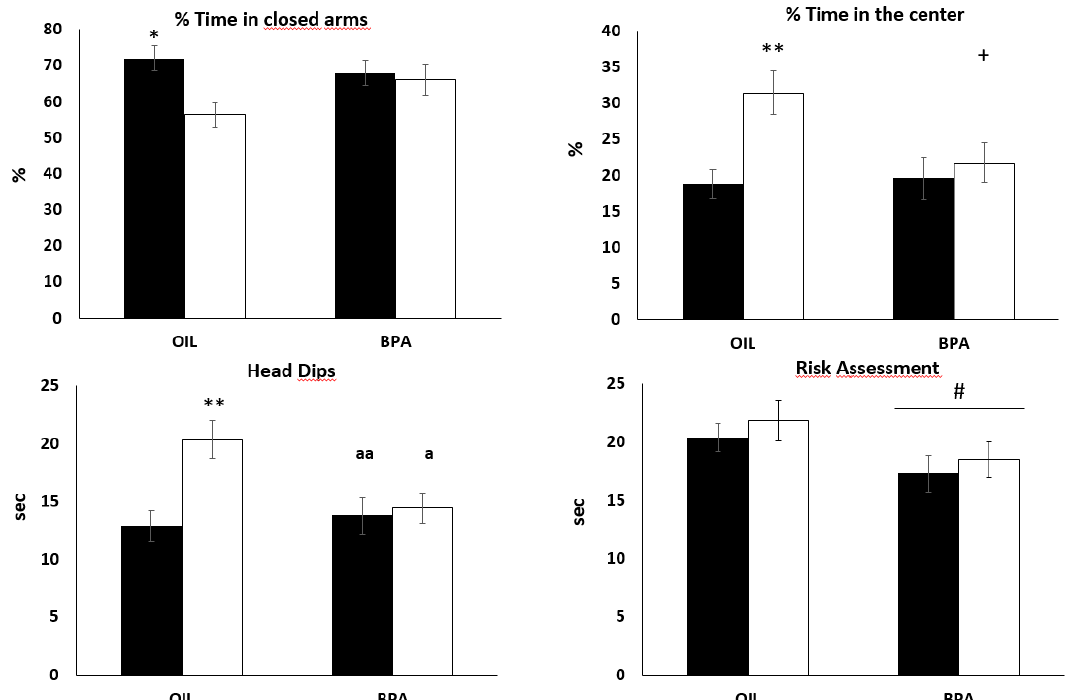
Figure 2. Effects of prenatal BPA exposure on behaviors in the elevated plus maze. (OIL: 14 males and 14 females; BPA: 14 males and 14 females); Dark columns = males. * p < 0.05, OIL males vs. OIL females; ** p < 0.01, OIL males vs. OIL females; + p = 0.06, OIL females vs. BPA females; a p < 0.05, OIL females vs. BPA females; aa p < 0.01, OIL females vs. BPA males; # p < 0.05 BPA group vs. OIL group. Data are presented as mean ± SE.